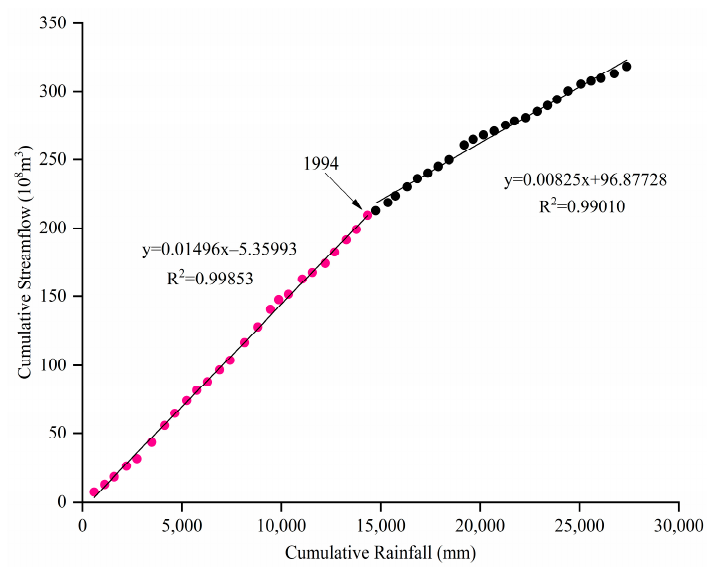
Figure 7. Land-use/cover changes of Beiluo River Basin in 1980 and 2015. Figure 7. Land ‐ use/cover changes of Beiluo River Basin in 1980 and 2015.